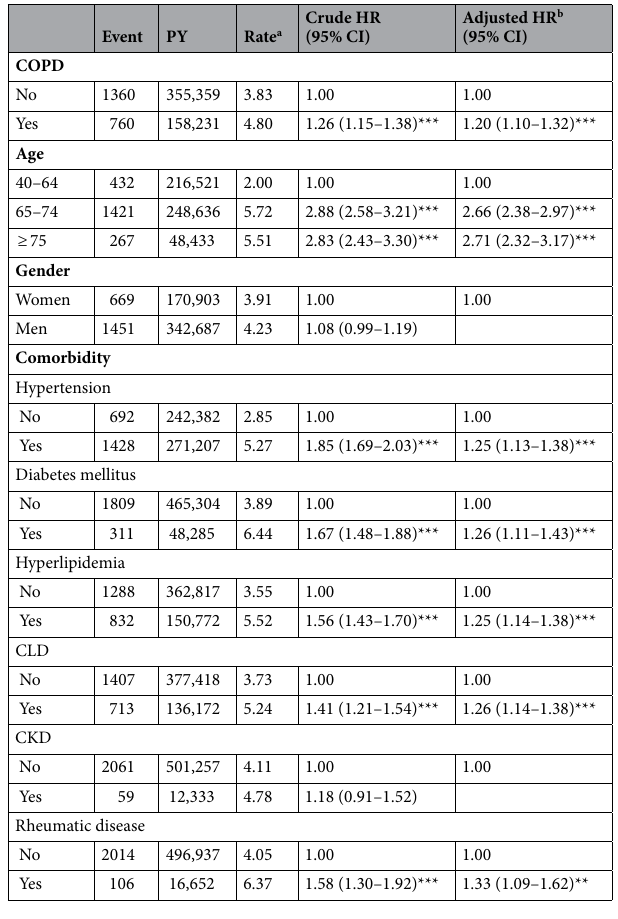
Table 2. Incidences and hazard ratios of age-related macular degeneration for potential risk factors. CI, confidence interval; CKD, chronic kidney disease; CLD, chronic liver disease and cirrhosis; COPD, chronic obstructive pulmonary disease; HR, hazard ratio; PY, person-years. ** p < 0.01, *** p < 0.001. a Incidence rate per 1000 person-years. b Multivariable analysis including age and comorbidities of hypertension, diabetes, hyperlipidemia, CLD, and rheumatic disease.